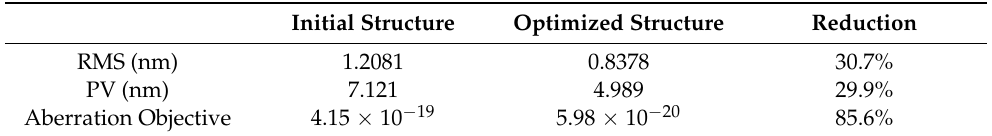
Table 3. Performance comparison between the optimized and initial structure of the secondary mirror in the vertical optical axis.